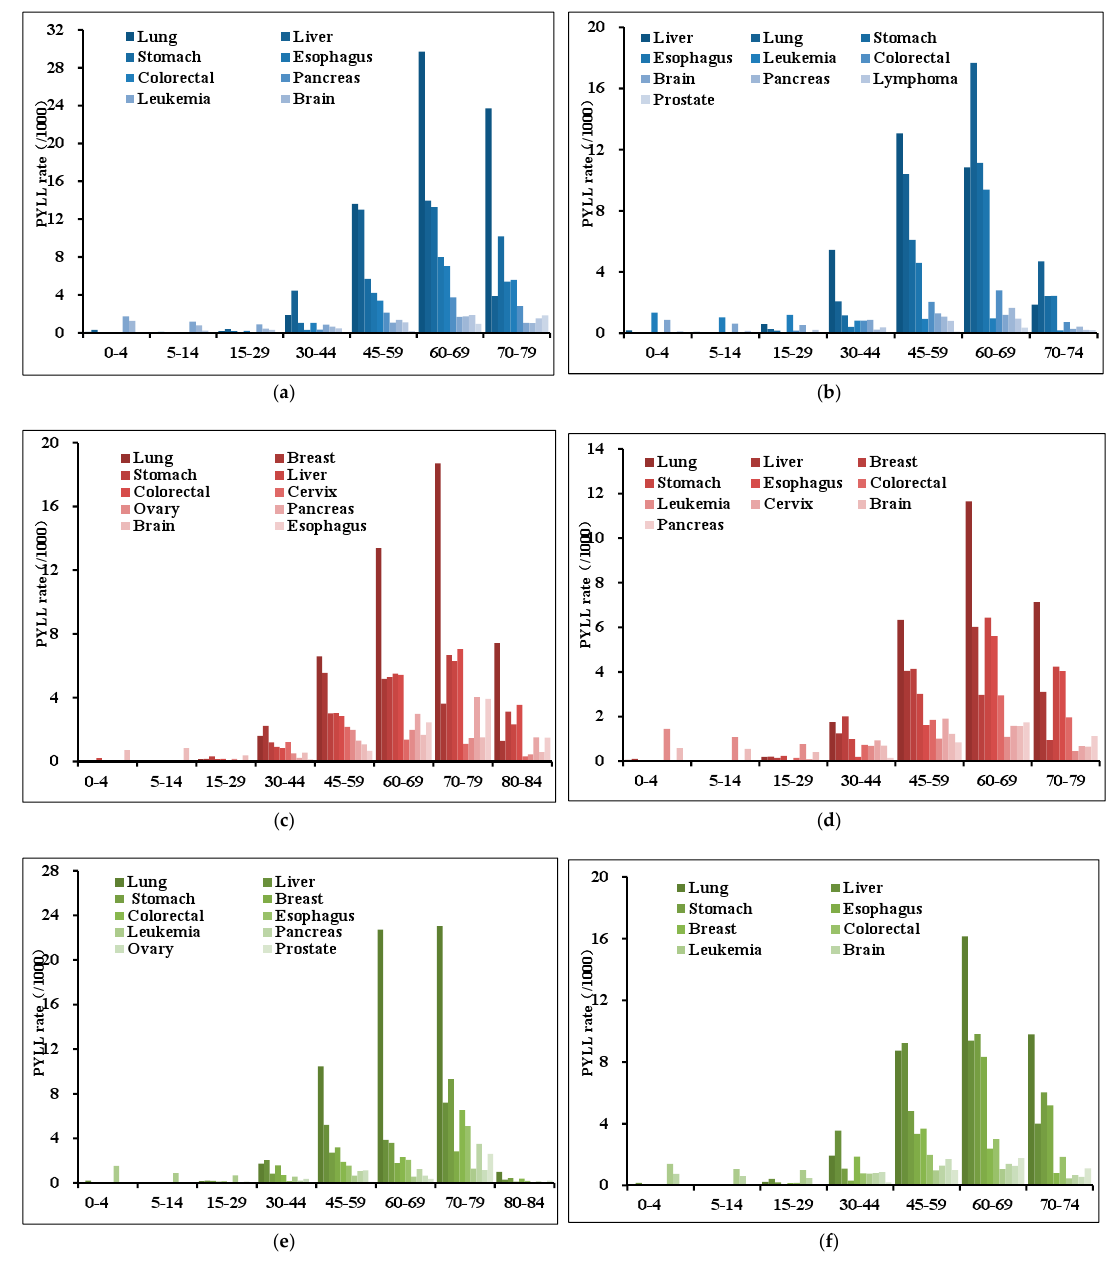
Figure 3. PYLL age distribution of high-death-risk cancers in urban and rural areas, 2013. ( a ) urban males; ( b ) rural males; ( c ) urban females; ( d ) rural females; ( e ) urban both; ( f ) rural both.